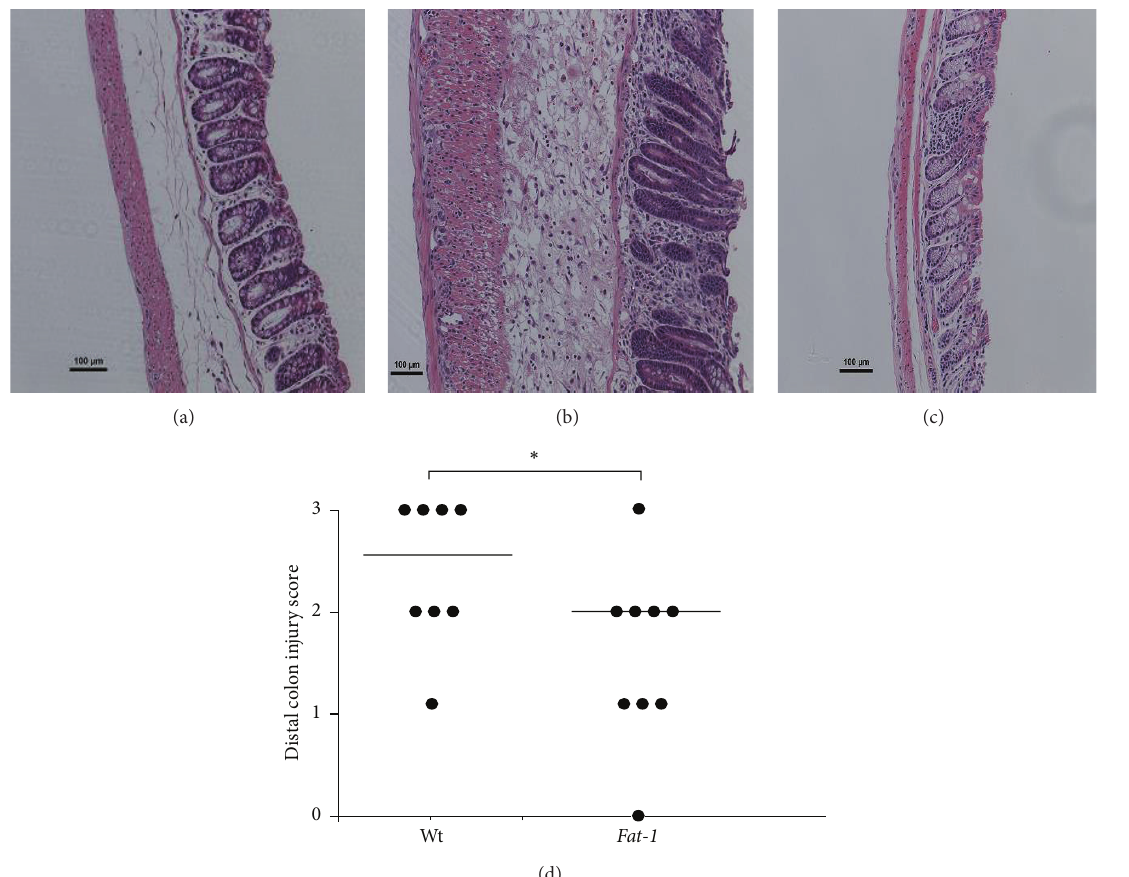
Figure 1: The degree of distal colon histological injury/damage in Fat-1 and Wt TNBS-treated mice ( 𝑛 = 8 -9/genotype). ((a) and (b)) Representative images (100x magnification, scale bar = 100 𝜇 m) of TNBS-treated Fat-1 and Wt mice, (c) Wt saline control treated (injury score = 0) distal colons, and (d) injury scores (0–3) in the distal colon from Wt and Fat-1 TNBS-treated mice, respectively. Data were analyzed using the Kruskal-Wallis test ( 𝑃 ≤ 0.05 ). Median values are shown and significant differences between genotypes are marked with an asterisk ( 𝑃 ≤ 0.05